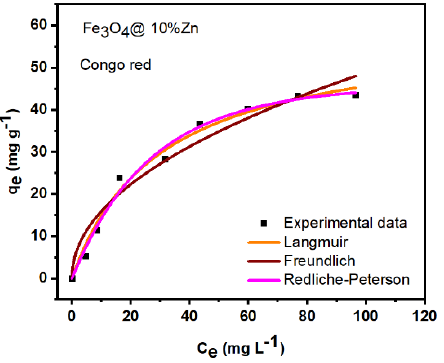
Figure 19. Isotherm modeling and experimental data for Fe 3 O 4 @10%Zn nanoparticles in pH equal 6.